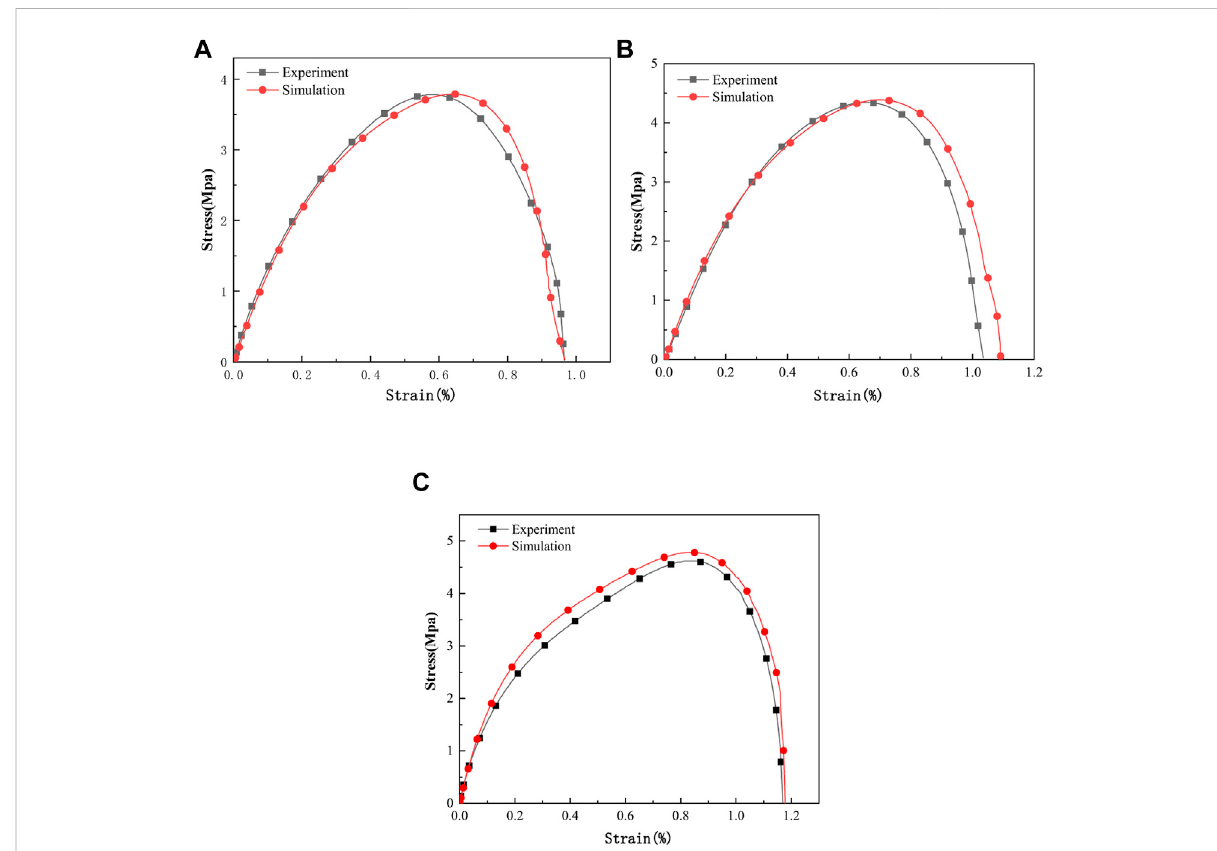
FIGURE 6 Three stress – strain curves of the experiment and simulations. (A) _ ε = 24.8 s − 1 , (B) _ ε = 33.2 s − 1 , (C) _ ε = 45.1 s − 1